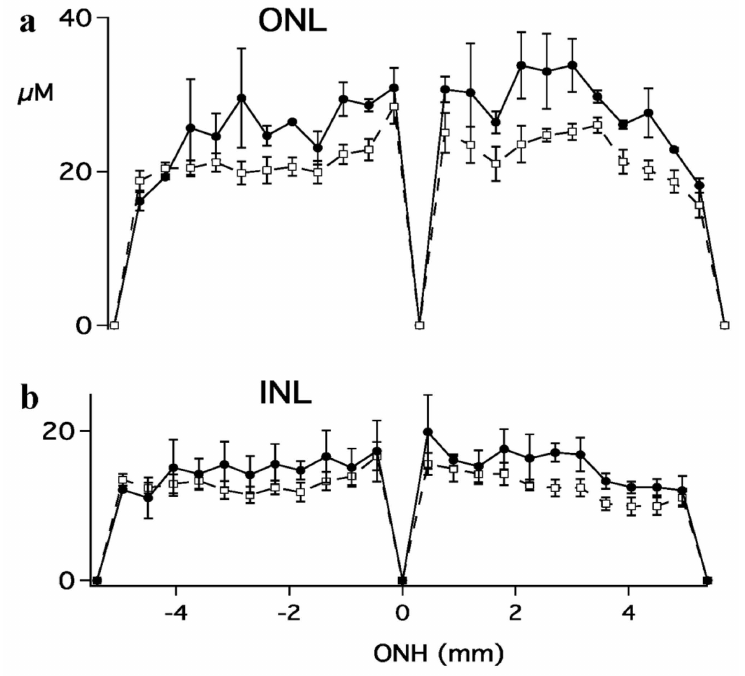
Figure 6. The thickness of ( a ) outer and ( b ) inner nuclear layers plotted as a function of distance from the ONH. Measures were made along a vertical meridian within 2 mm of the ONH. The negative values on the x –axis indicate inferior retina, while positive indicate superior